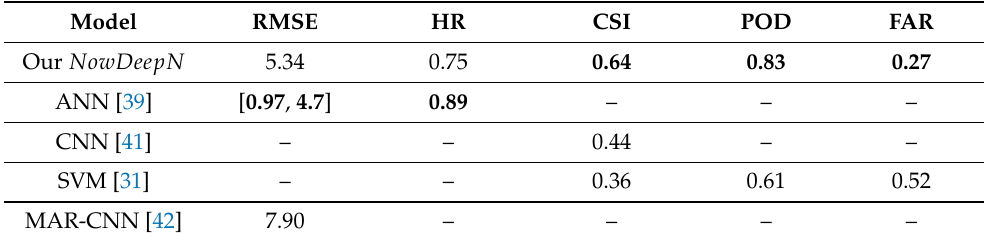
Table 4. Comparison to the work of Yan Ji [39], Han et al. [31,41] and Yan et al. [42].